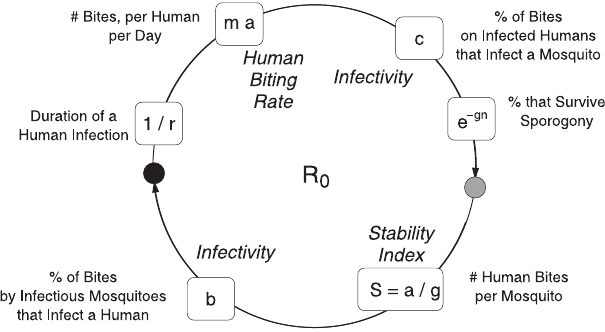
Figure 1. The Life Cycle Model and R 0 The basic reproductive number, R 0 , is derived by computing the expected number of vertebrate hosts or vectors that would be infected through one complete generation of the parasite by a single infected mosquito or a single infected human. The underlying mathematical model, by Ross [11] and Macdonald [12] and with a slight modification by Smith and McKenzie [27], is a quantitative description of the idealized life cycle. This diagram follows one by Macdonald et al. [23]. The parameters are described in Table